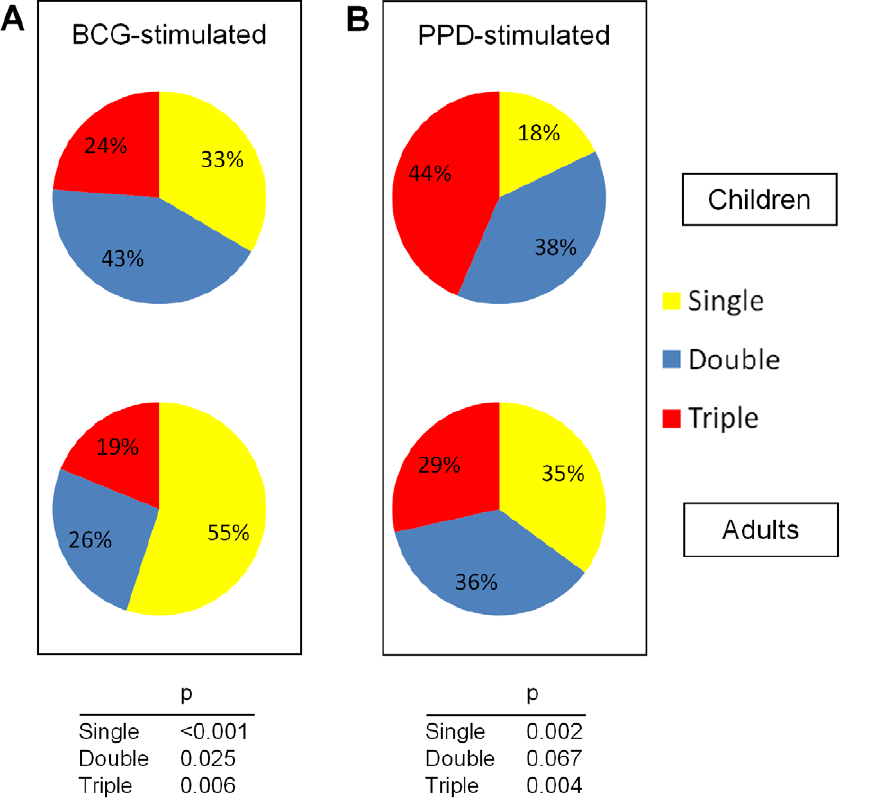
Figure 5. The fraction of single-, double-, and triple- cytokine-producing CD4 T cells relative to the total population of Th1-cytokine producing cells in children (n=13) and adults (n=13) following invitro stimulation with antigens (A) BCG and (B) PPD. Differences were compared using a Mann-Whitney test.